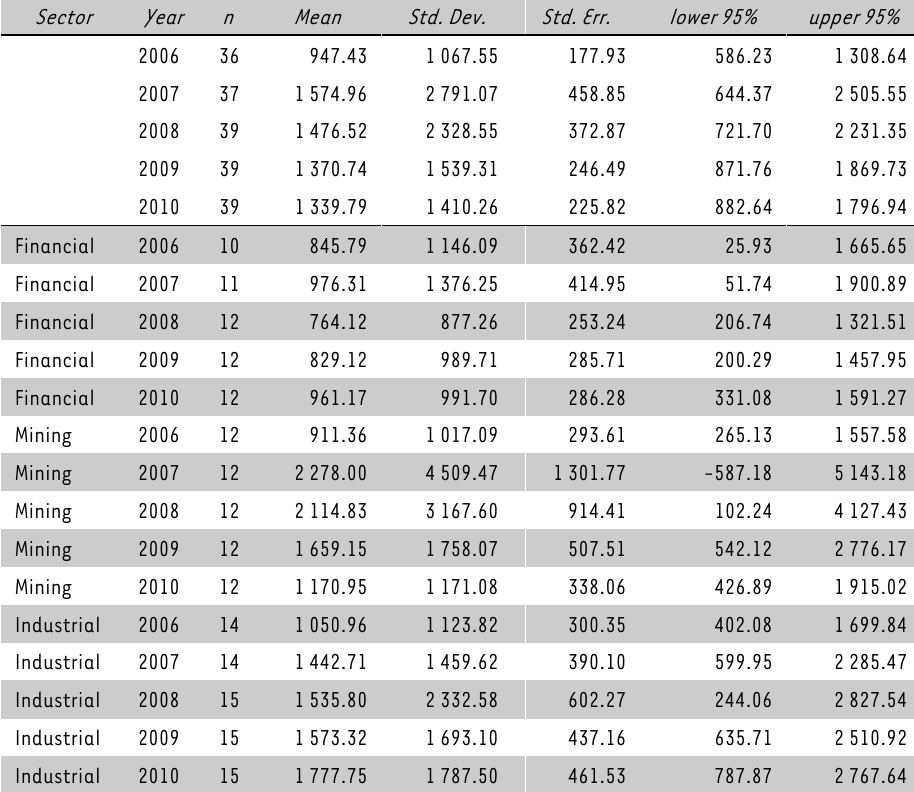
TABLE 5: Descriptive statistics for ‘other’ remuneration All figures except for n are given in thousands, and refer to South African